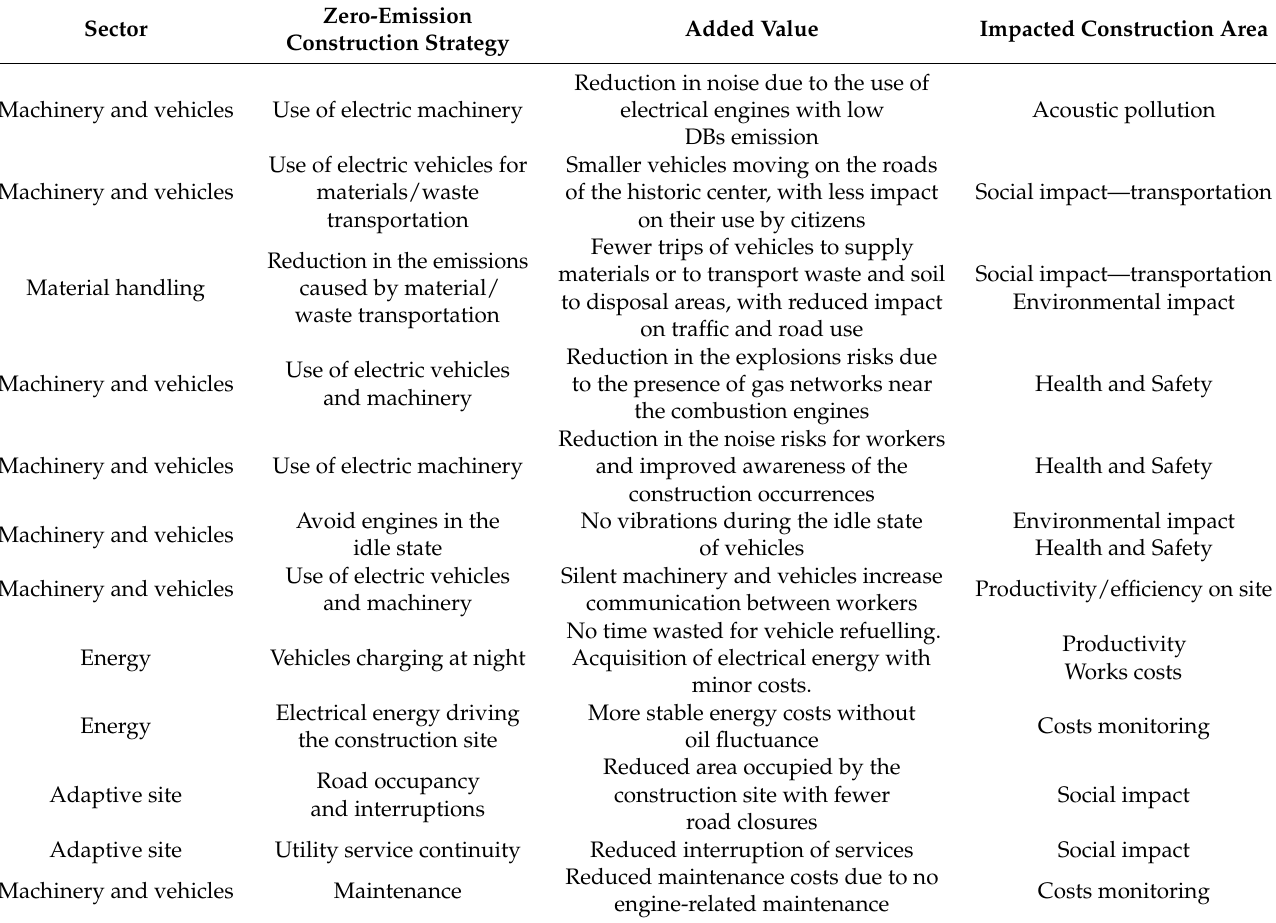
Table 5. Additional impacts of zero-emissions strategies on construction